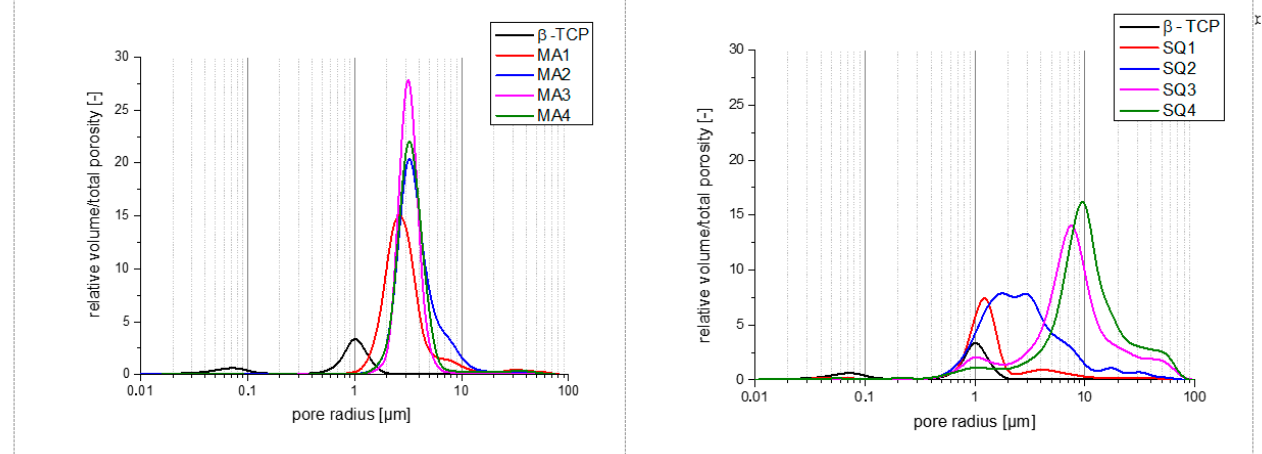
Table 2. Mercury porosimetry results of sintered scaffolds.